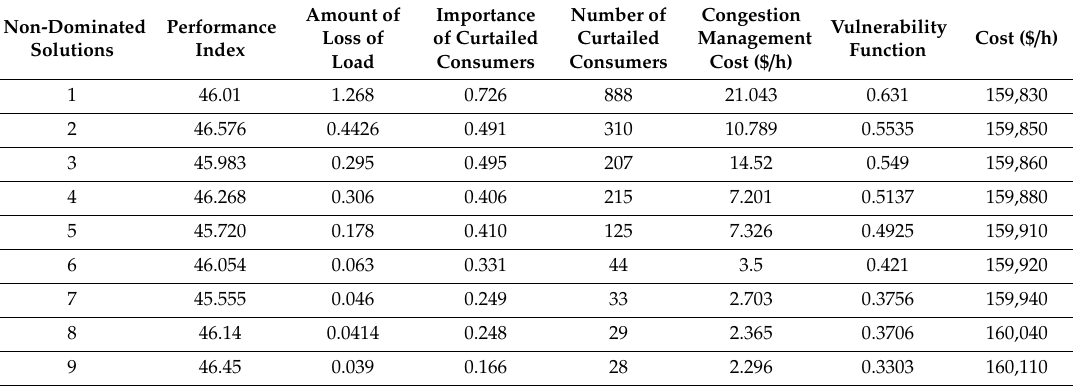
Table 6. Average of Resilience Metrics for the Obtained Non-Dominated Set in IEEE 118-Bus Test System.